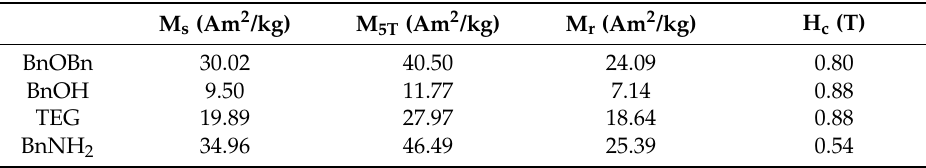
Table 1. Overview of the saturation magnetization M s , magnetization at 5 T M 5T , remanence M r